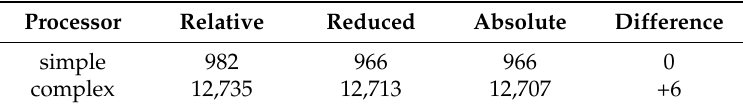
Table 7. The results of WCET reduction on program “select” (unit: